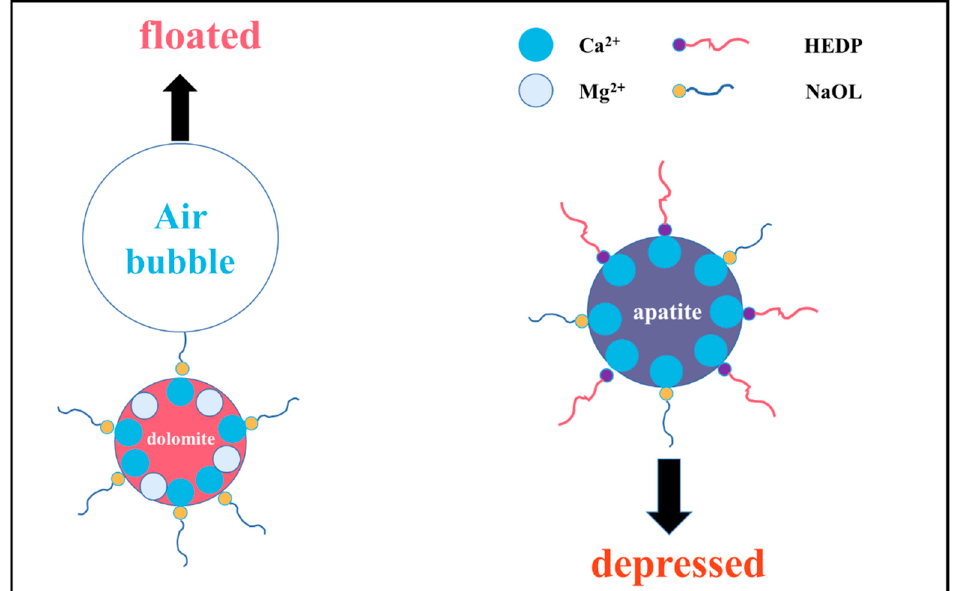
Figure 12. Schematic diagram of possible flotation separation mechanism of dolomite and fluorapatite at pH 6.0.